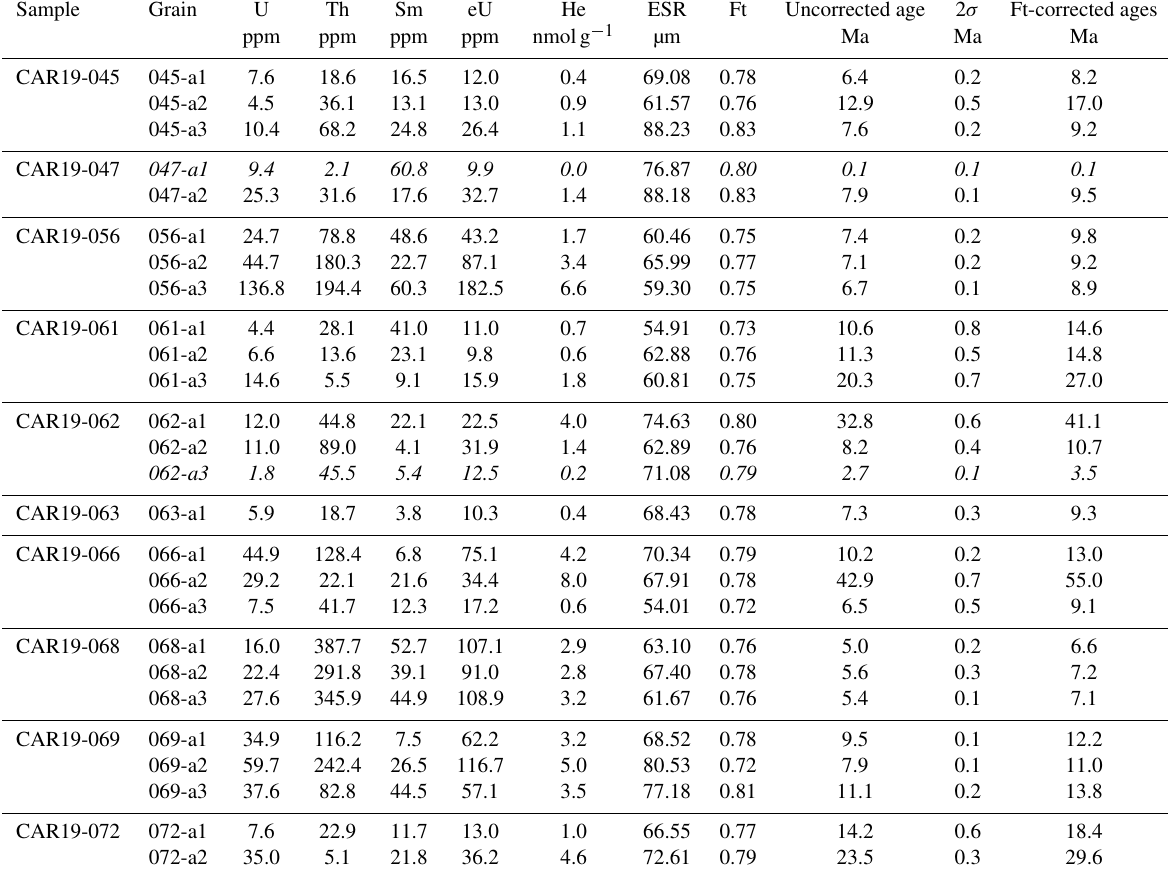
Table 3. Apatite (U–Th–Sm) / He data. Ages in italics are considered outliers and were not used in the models or for interpretations. eU: equivalent uranium content; ESR: equivalent spherical radius; 2 σ : weighted 2 σ analytical uncertainty from analysis of age standards.